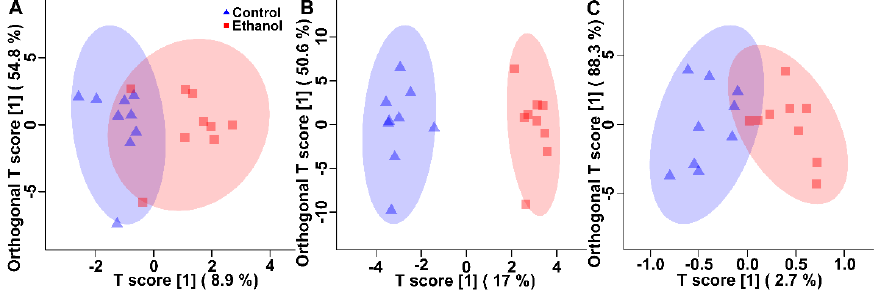
Figure 1. Orthogonal partial least squares determinant analysis score plots for the control treatment vs. the ethanol control treatment. ( A ) Kidney (Q 2 = 0.16, p = 0.076, R 2 = 0.65, p = 0.062). ( B ) Liver (Q 2 = 0.85, p < 0.001, R 2 = 0.97, p < 0.050). ( C ) Breast muscle (Q 2 = 0.66, p < 0.001, R 2 = 0.76, p < 0.050). Each